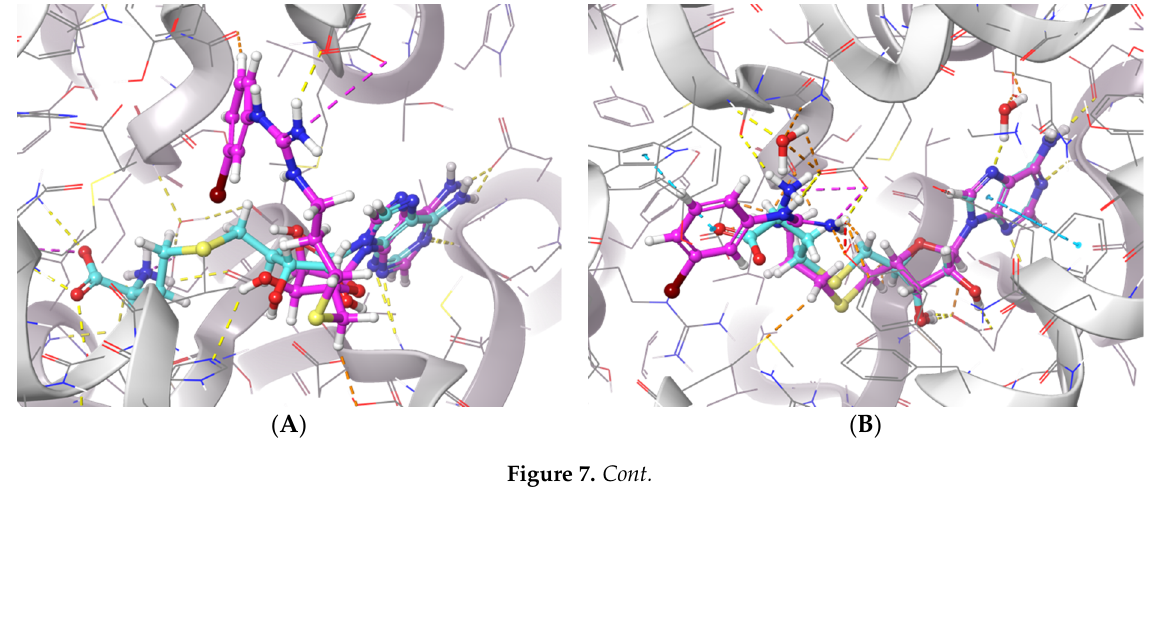
Figure 7. The in silico interaction of II757 inside the pocket of ( A ) PRMT1 (PDB: 6nt2), ( B ) PRMT4 (PDB: 6s79), ( C ) PRMT5 Figure 7. (PDB: 6ckc), and ( D ) PRMT7 (PDB: 4m37). II757 is shown in the magenta stick and ball model.